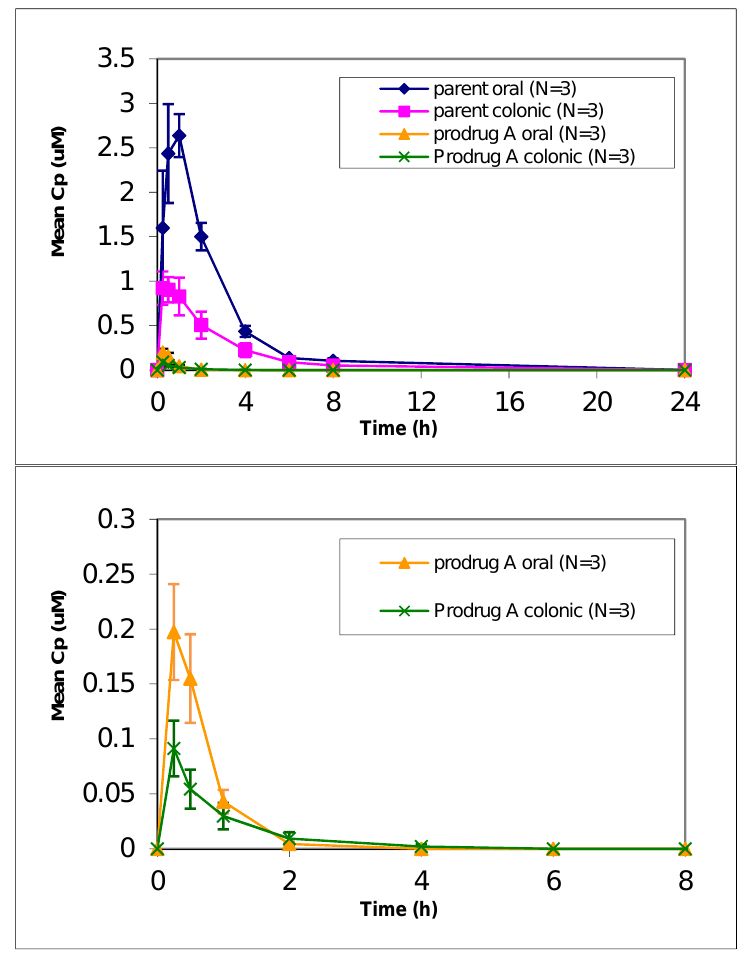
Figure 1. Mean plasma concentration vs . time profiles of prodrug A and parent following oral and colonic administration of prodrug solution to fasted Beagle dogs at a dose of 4 mpk (mean ± SE). [bottom graph is zoom in for prodrug only